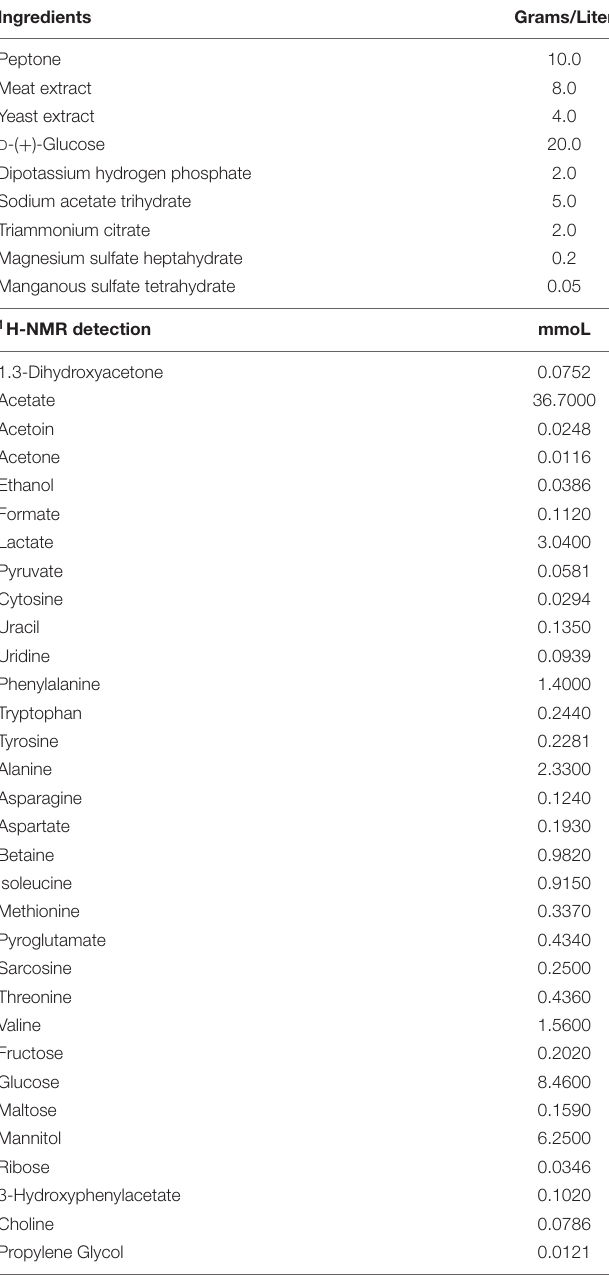
TABLE 4 | Composition of 69966 MRS Broth ( Lactobacillus Broth acc. to De Man, Rogosa, and Sharpe) Datasheet Sigma-Aldrich Co.